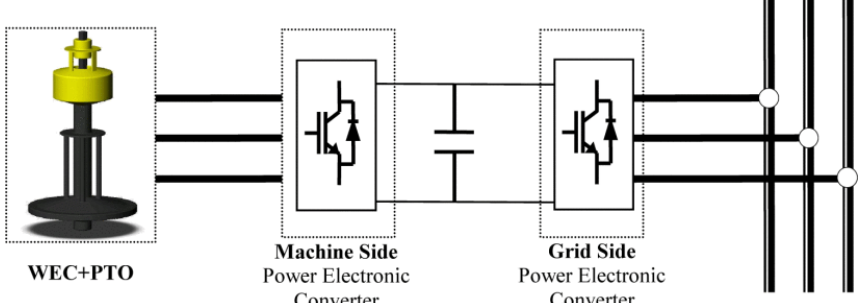
Figure 16. Simplified electrical diagramam of a WEC+PTO with linear generator connected to the grid.